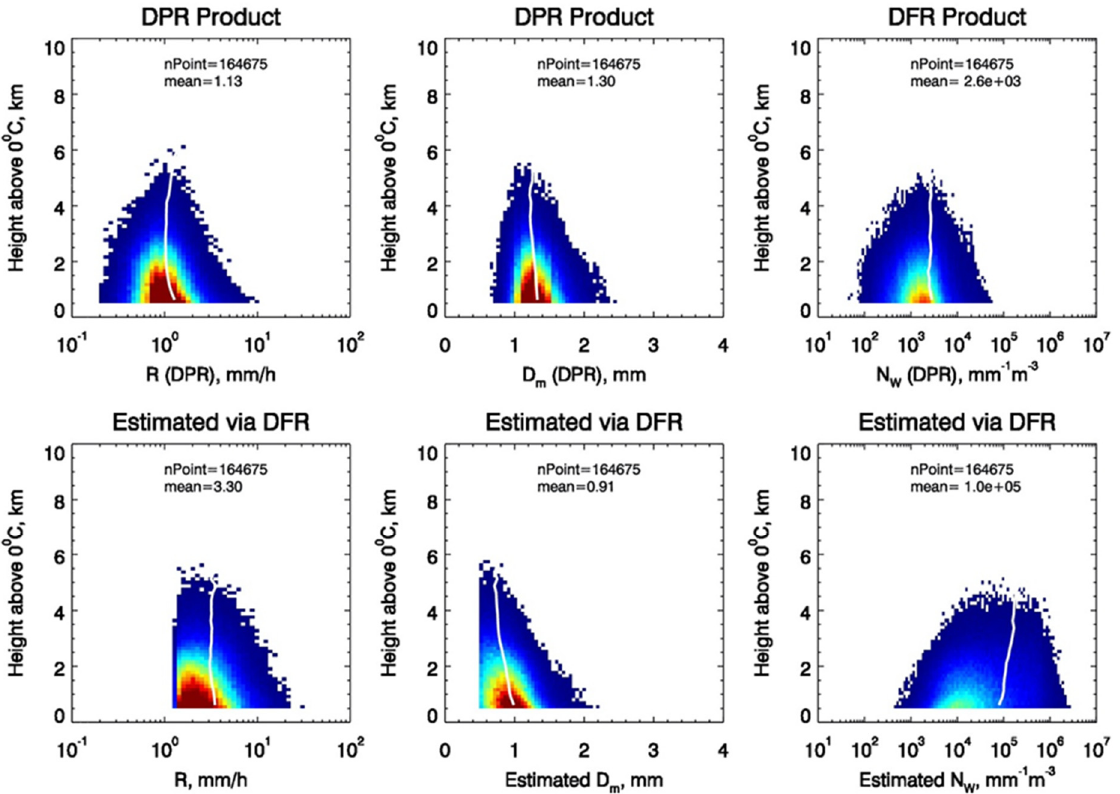
Figure 6. PDFs of R, D m , and N w as a function of the height above 0 °C freezing level, obtained from the DPR standard product ( top row) and the DFR technique ( bottom row). The white lines represent the mean of the data at each height; “nPoint” is the total number of data points and “mean” denotes mean value.